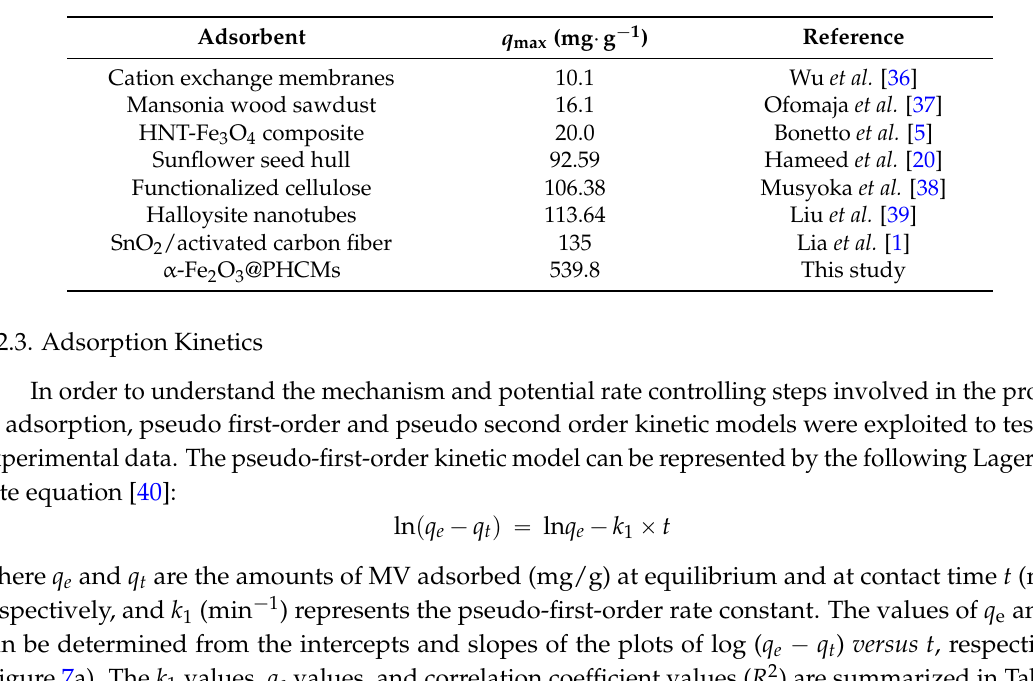
Table 2. Comparison of adsorption capacities of various adsorbents for MV.